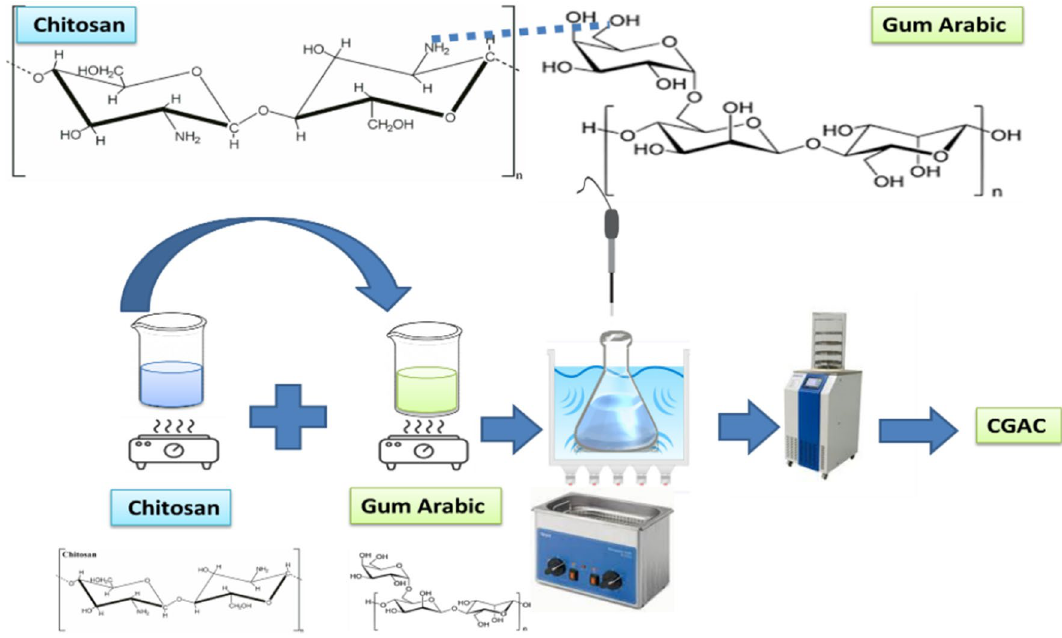
Figure 1. An image for the preparation process of CGAC